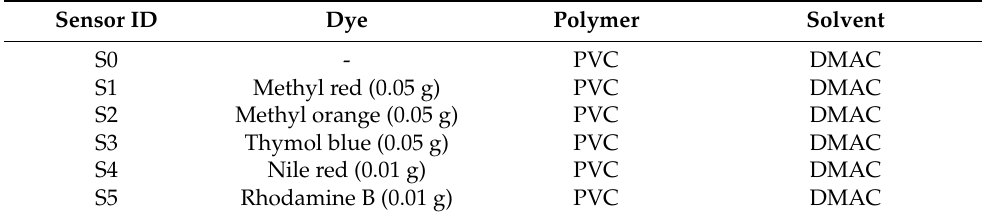
Table 2. Composition of the pH-sensing solution to prepare different optical-fiber sensing elements of an array.